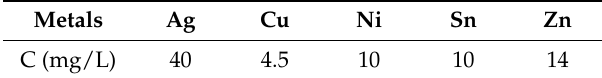
Table 2. The composition of the raffinate after selective extraction of gold(III) and copper(II) by Cyanex 272 and LIX 63 at 5 M HCl.